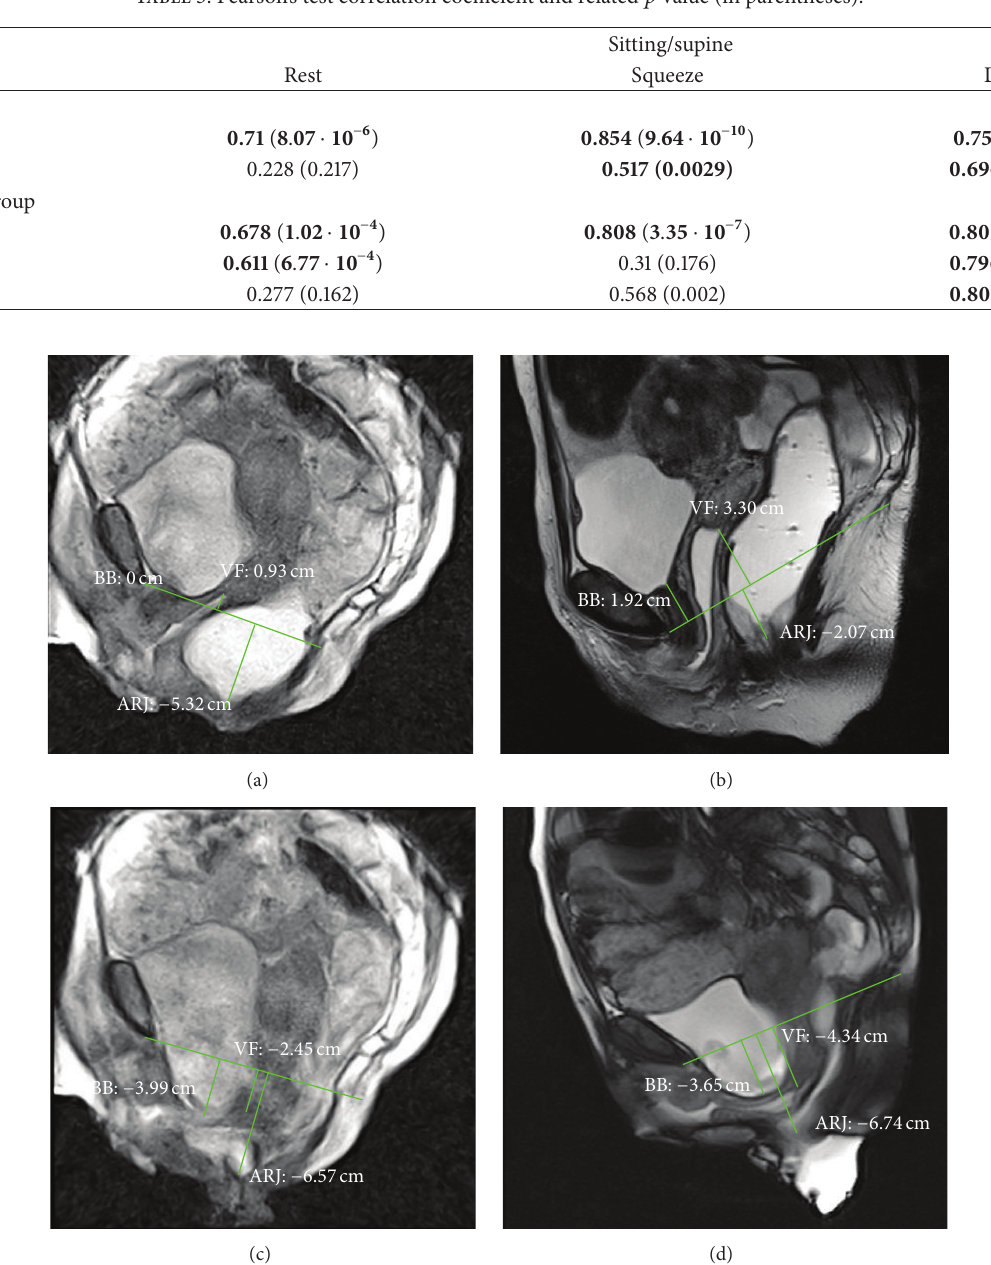
Figure 4: MR Defecography. Rest phase in sitting (a) and supine (b) position. Evacuation phase in sitting (c) and supine (d) position. The pathological fixed descent was detected only in sitting position in rest phase (a). In evacuation phase, the MR examination in supine position overestimates the dynamic descent; the rectocele is seen only in sitting position. BB: bladder base; VF: vaginal fornix; ARJ: anorectal